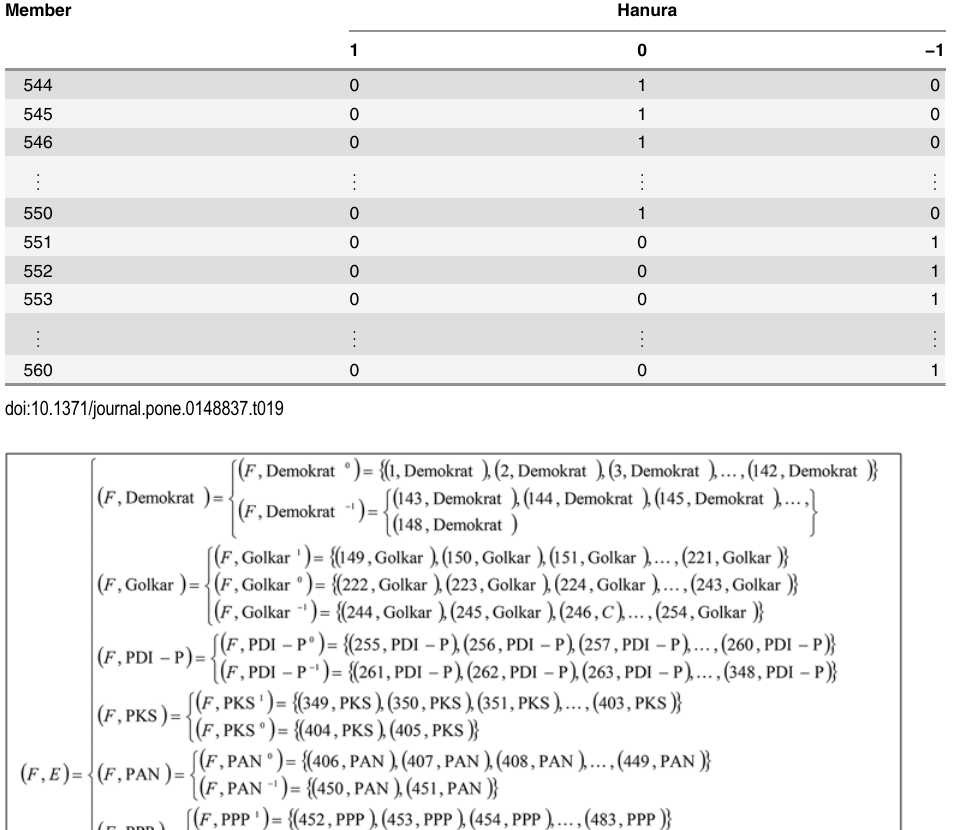
Table 19. A decomposition of Table 10 into multi-tables of Boolean-Valued for Hanura. Member